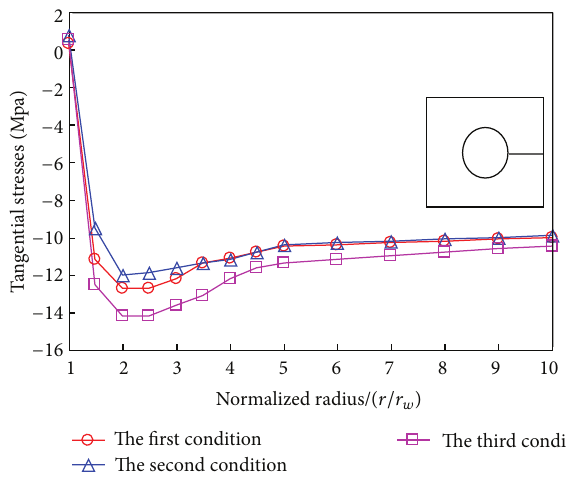
Figure 18: Distribution of the radial stress in borehole under different conditions.